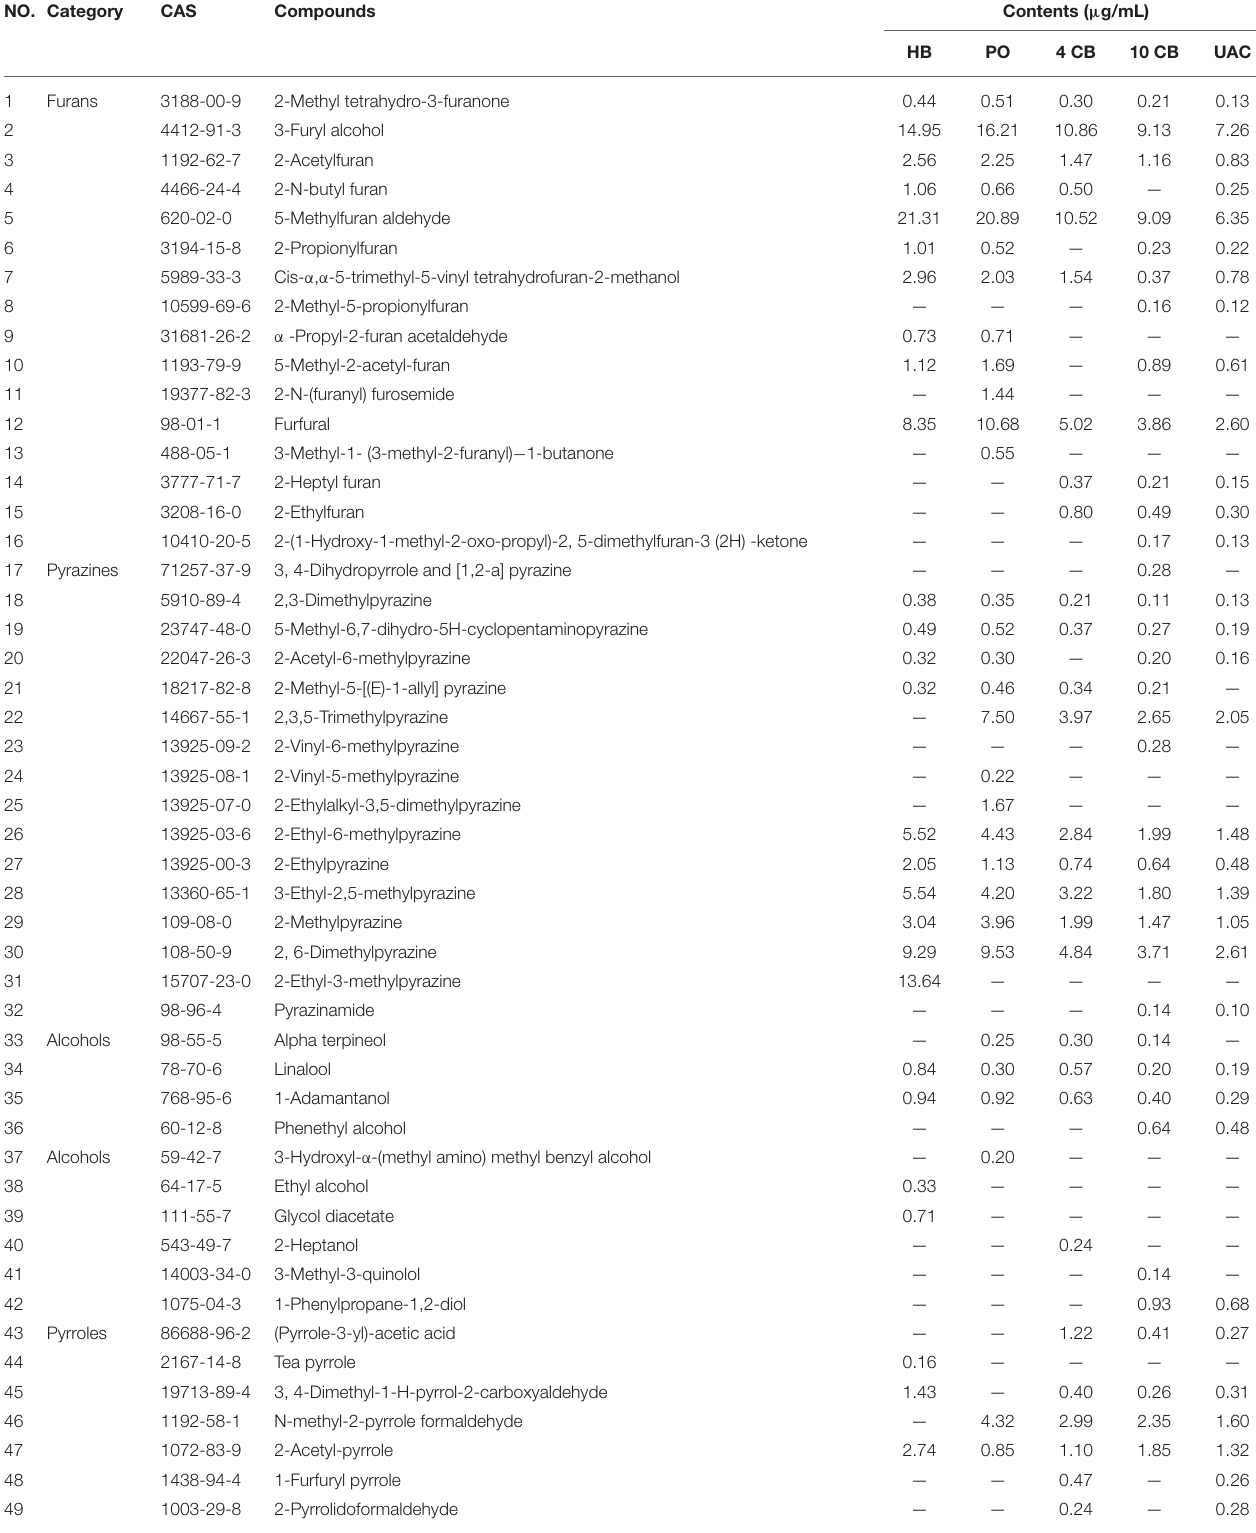
TABLE 3 | Volatile components in coffee extracts with different brewing methods. NO.